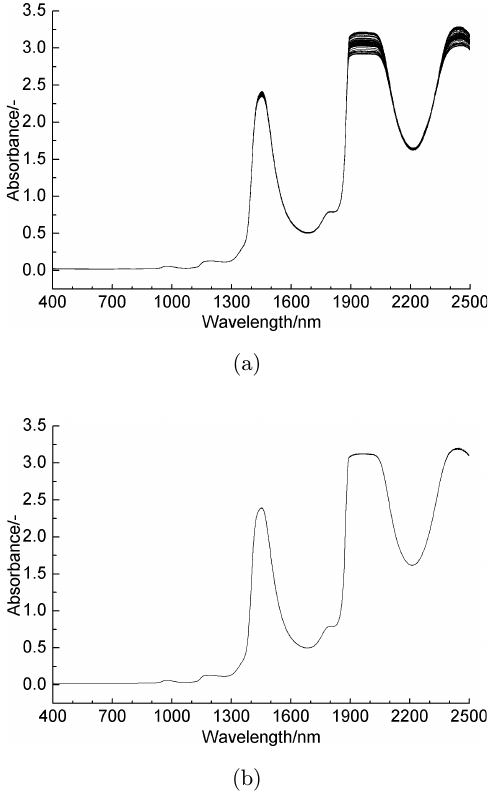
Fig. 6. Spectra in the entire scanning region (400 – 2498 nm) for (a) 72 TCP – Tris – HCl mixture samples and (b) double- distilled